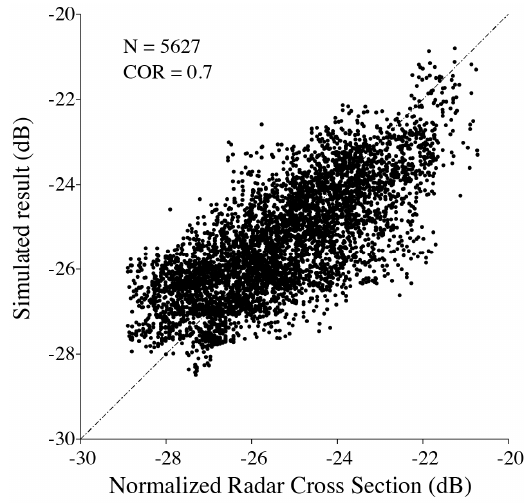
Figure 7. Comparison between observed NRCS of VH-polarization GF-3 SAR and simulated results using the empirical algorithm.